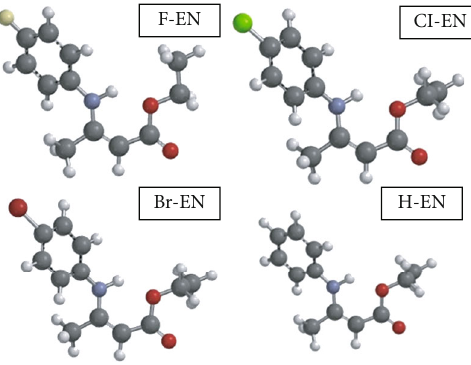
Figure 9: Optimized molecular structure of F-EN, Cl-EN, Br-EN, and